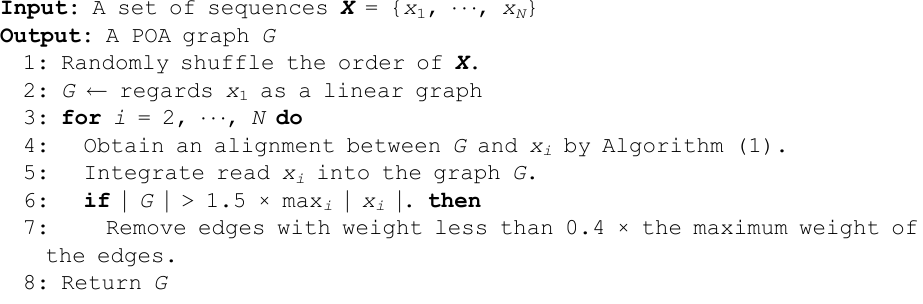
Algorithm 2 The algorithm to construct a POA